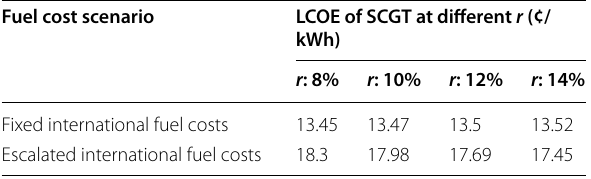
Table 3 LCOE of SCGT at different discount rates and in the two fuel